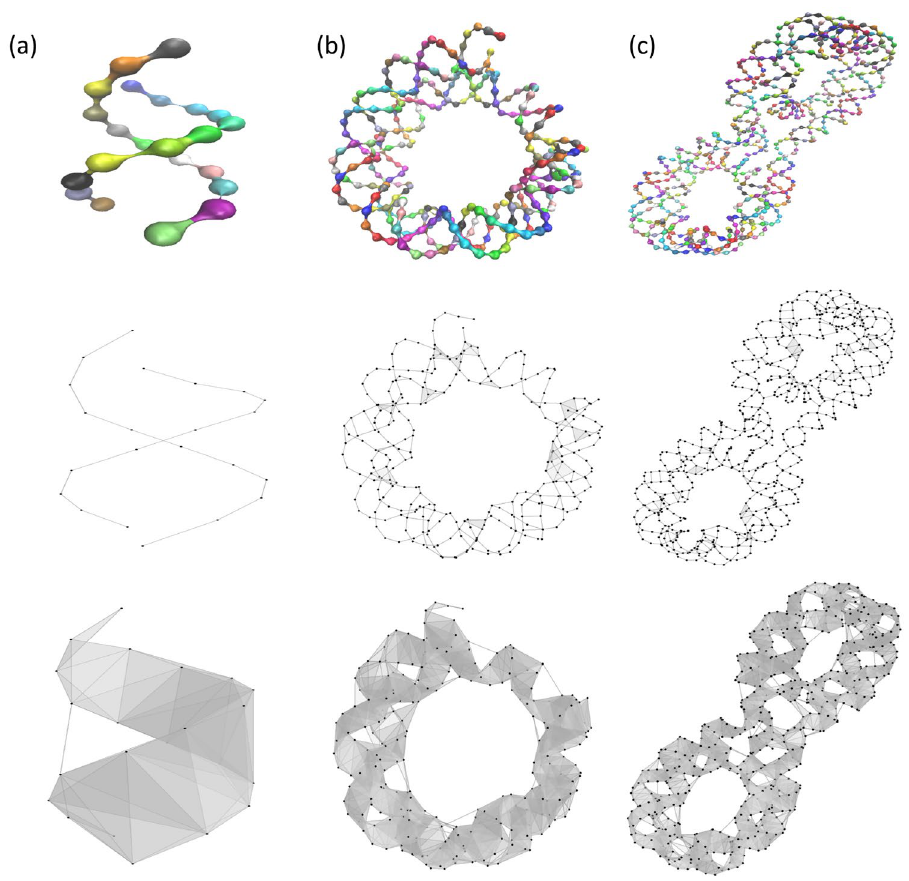
Figure 7. The illustration of three DNA structures, including DNA helix ( a ), nucleosome ( b ), and tetranucleosome ( c ), and their corresponding simplicial complexes at two different cutoff distances, i.e., 10 Å and 16 Å. The protein IDs for DNA helix, nucleosome, and tetranucleosome, are 330D, 6KVD and 1ZBB, respectively. The Vietoris-Rips complex is used.